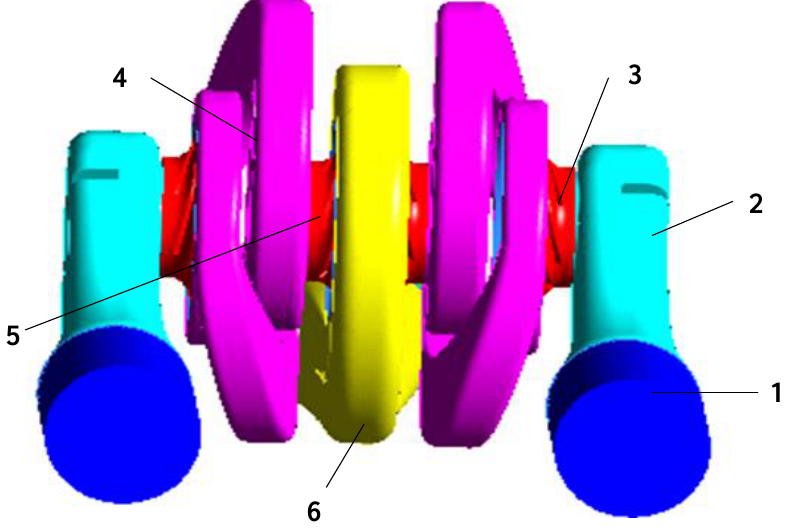
Figure 1. Calculation domain of DTDCP. ( 1 ) water inlet ( 2 ) suction chamber ( 3 ) first-stage single suction impeller, ( 4 ) inter-stage flow channel ( 5 ) second-stage double suction impeller ( 6 ) double-volute.